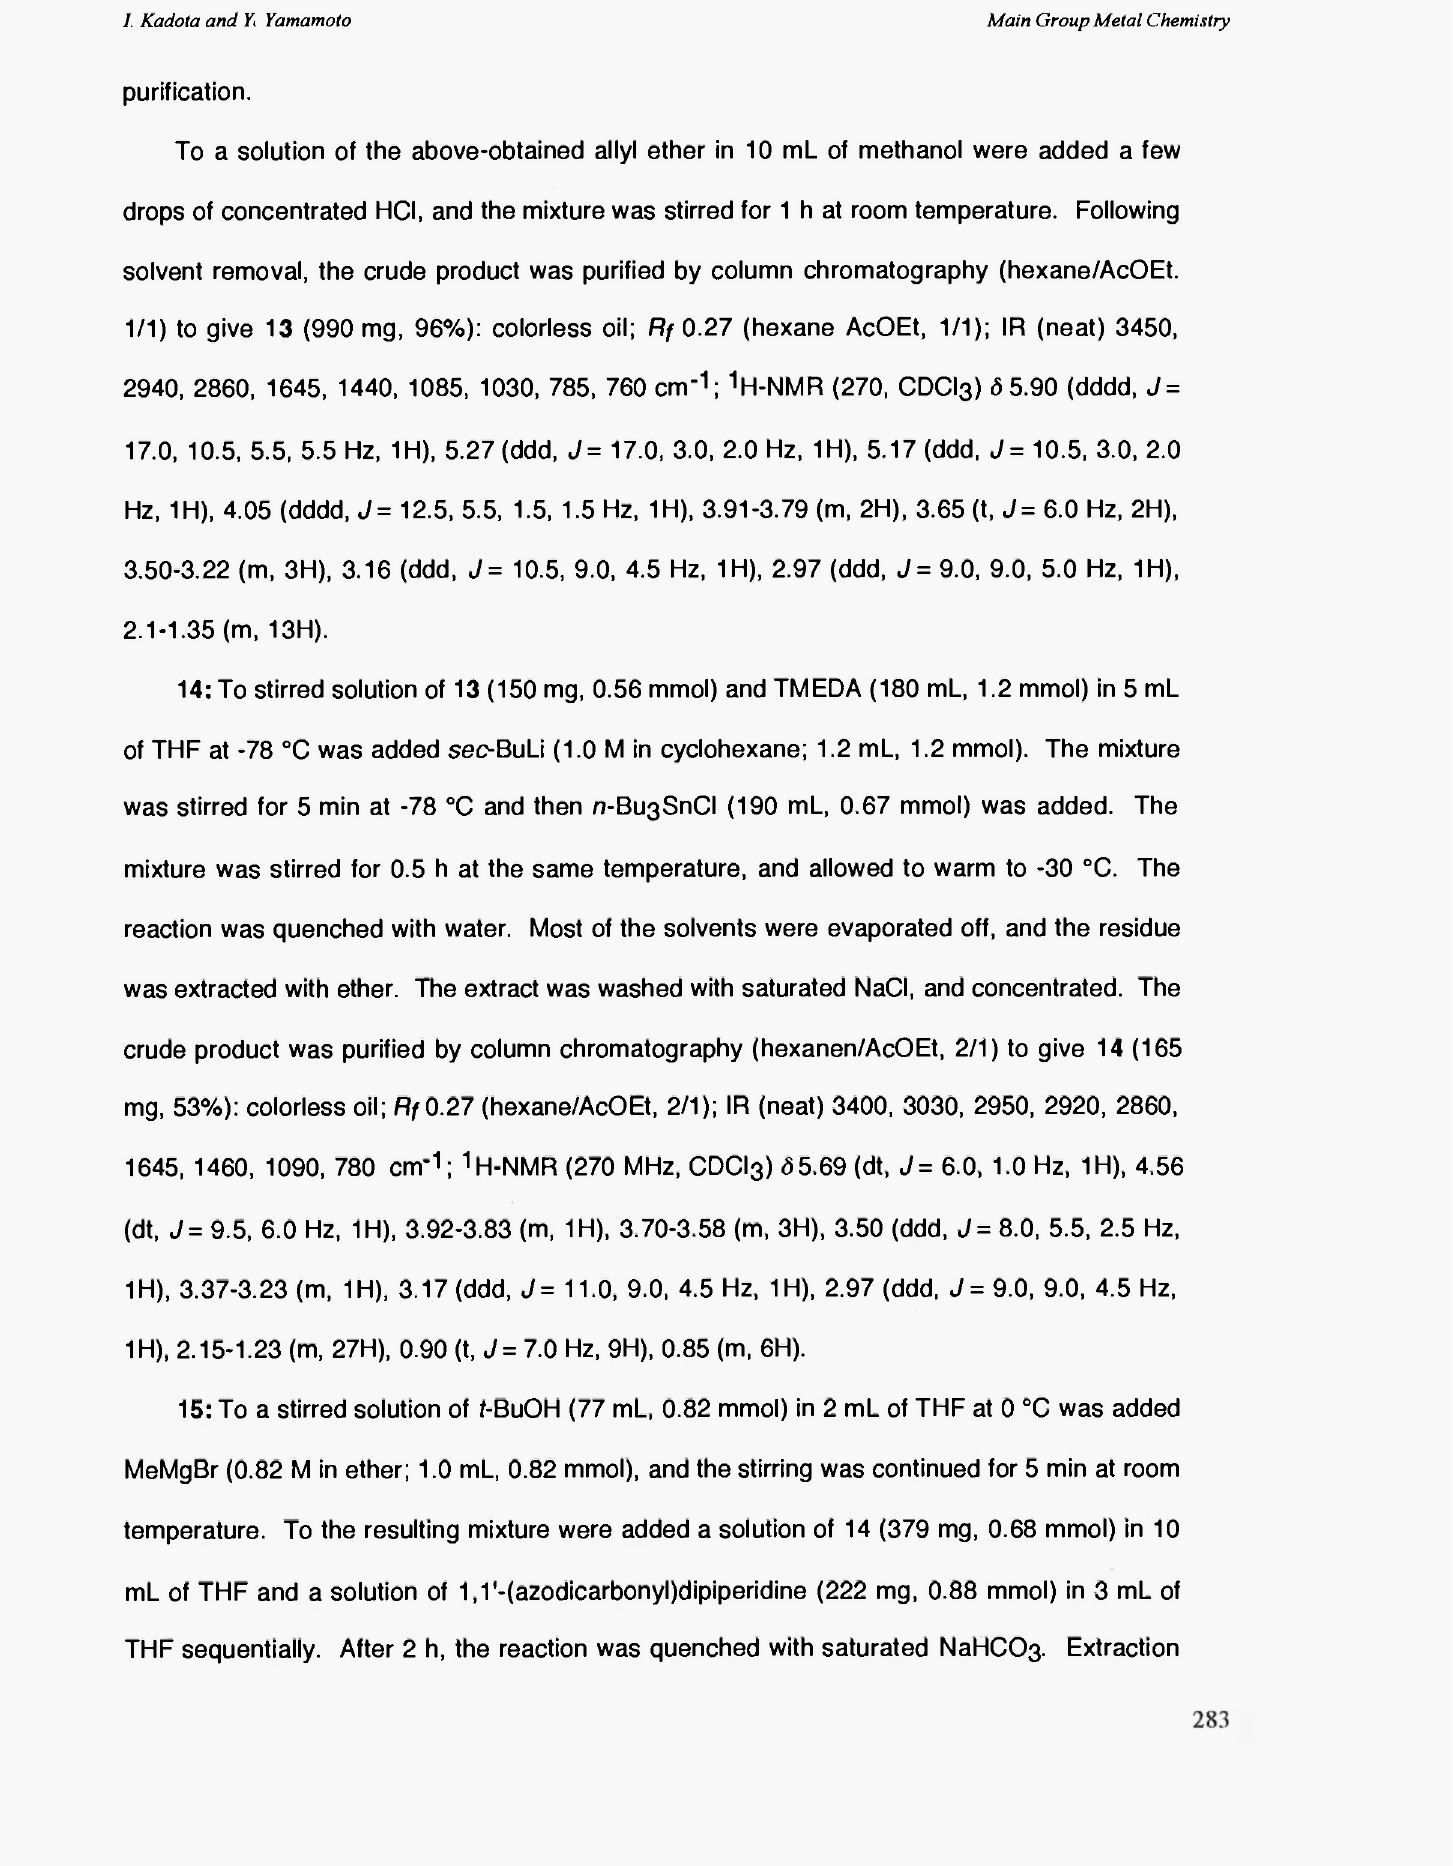
14: To stirred solution of 13 (150 mg, 0.56 mmol) and TMEDA (180 mL, 1.2 mmol) in 5 mL of THF at -78 °C was added sec-BuLi (1.0 Μ in cyclohexane; 1.2 mL, 1.2 mmol). The